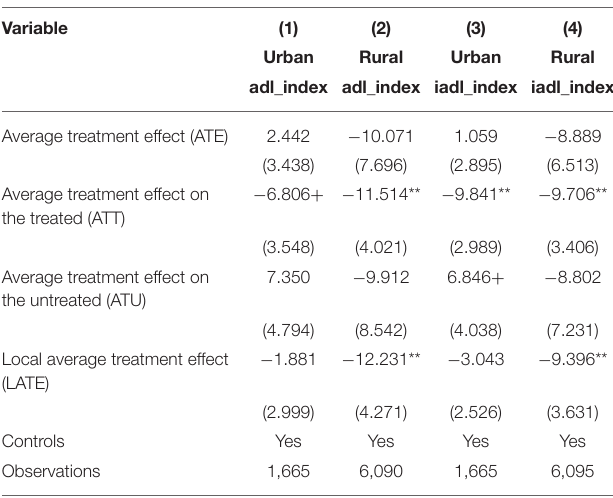
TABLE 7 | The robustness check